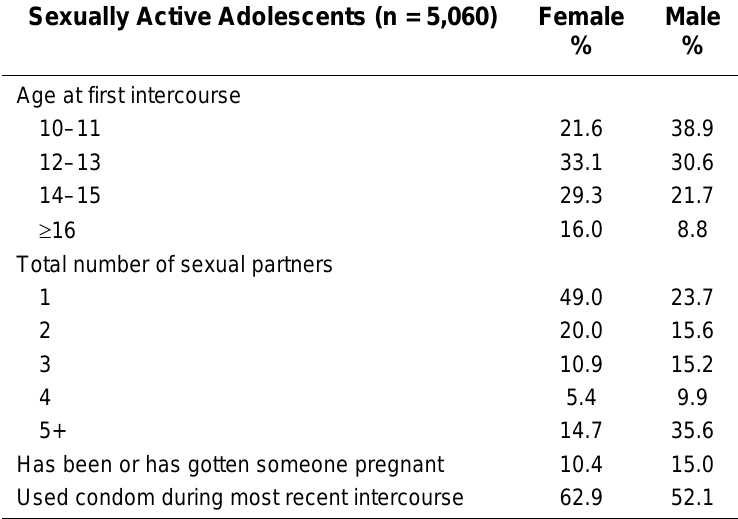
Frequencies of Sexual Behaviors in Caribbean